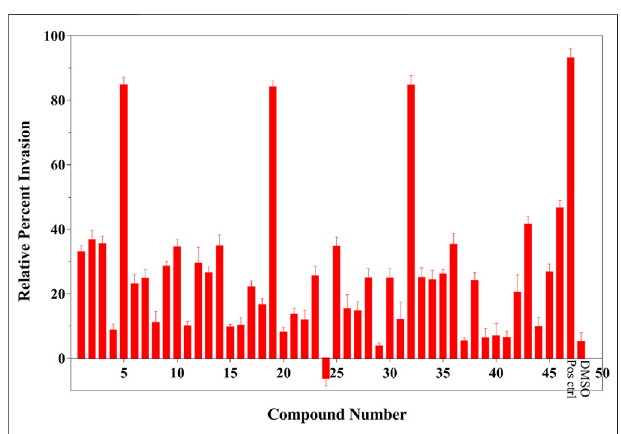
FIGURE 3 | Results of Salmonella invasion assay (legends: Pos ctrl: positive control, DMSO: negative control). This result was shown the average of triplicate